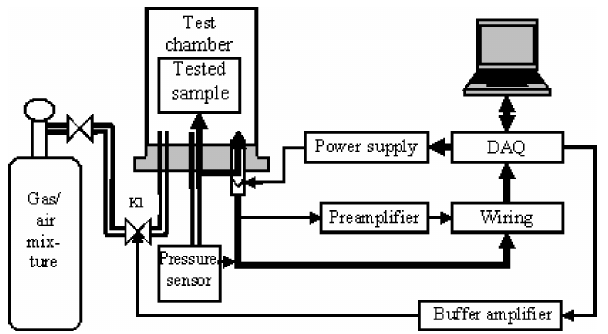
Figure 1. Automated gas-sensor parameter-measurement system